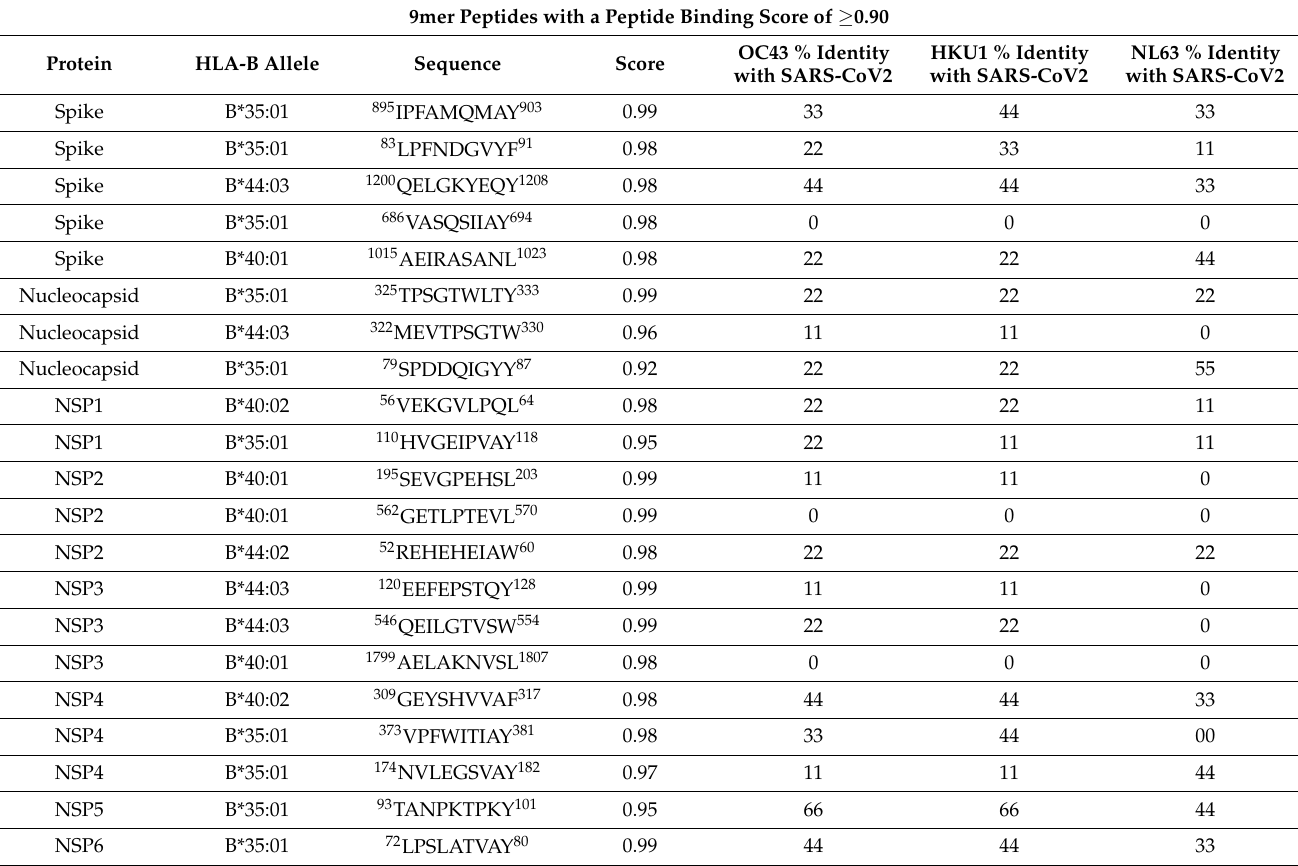
Table 2. Predicted CD8 + epitopes of the SARS-CoV2 virus restricted through HLA-B alleles. 9mer Peptides with a Peptide Binding Score of ≥